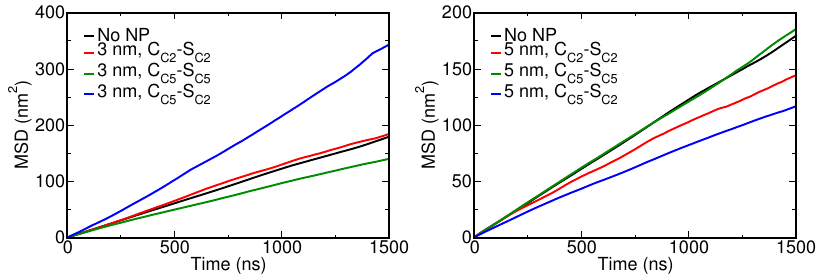
Figure 8. Mean square displacement vs. time for DPPC lipid in the presence of a 3 nm ( left ) and a 5 nm ( right ) Ag CG NP. The MSD was calculated for the last 2 µ s of a 10 µ s unconstrained CGMD simulation.